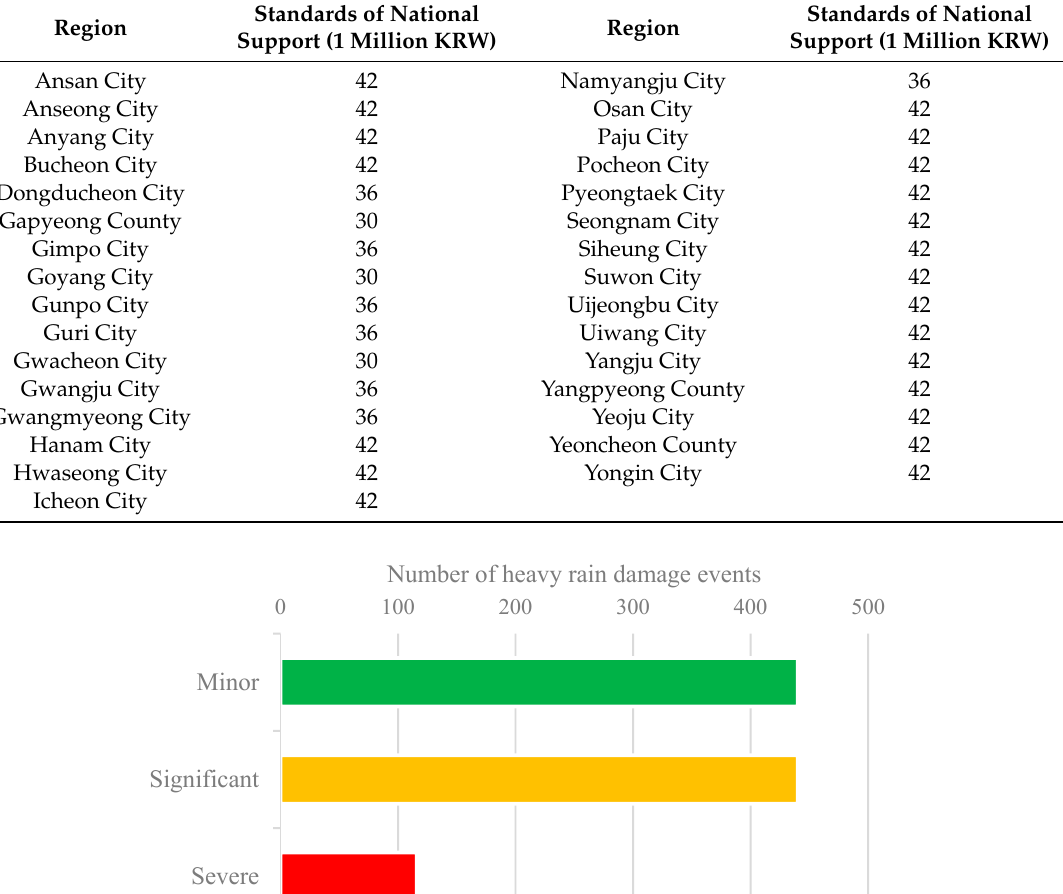
Table 2. Standards of national support by region.